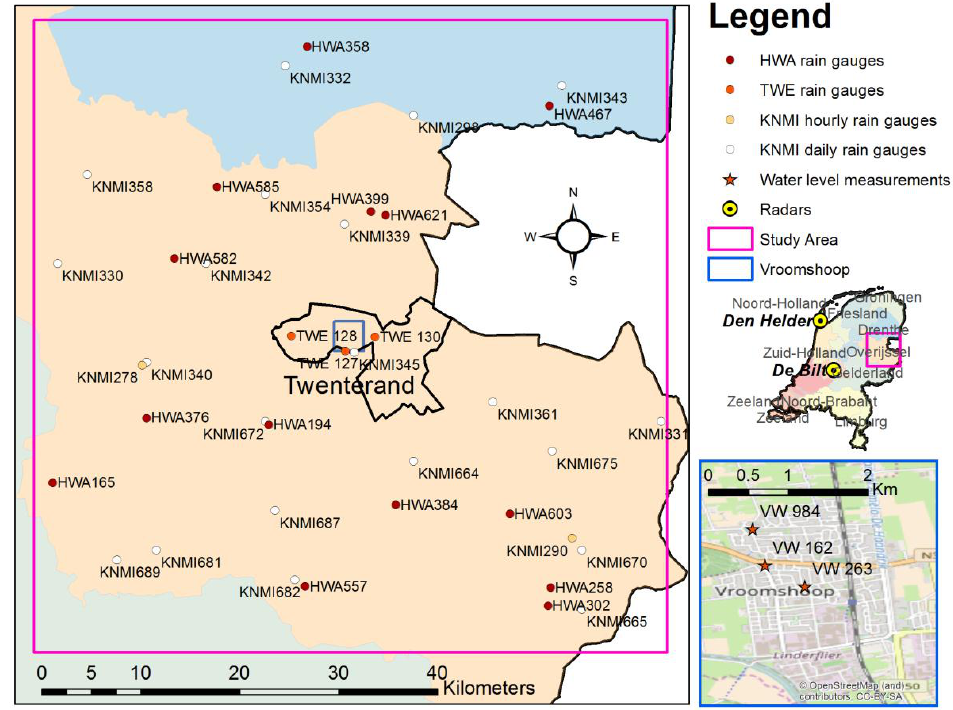
Figure 2. The Dutch study area is presented, including all the available rain gauge datasets. In the bottom-right panel, the three available water measurement points are shown.